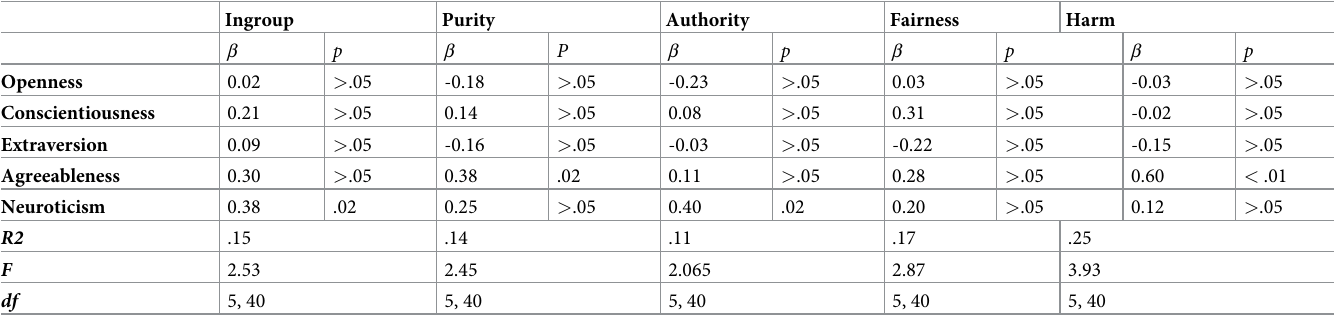
Table 4. Regression results of the big-5 personality (as independent variable) and moral foundations (as dependent variable) surveys. Ingroup Purity Authority Fairness Harm Openness Conscientiousness